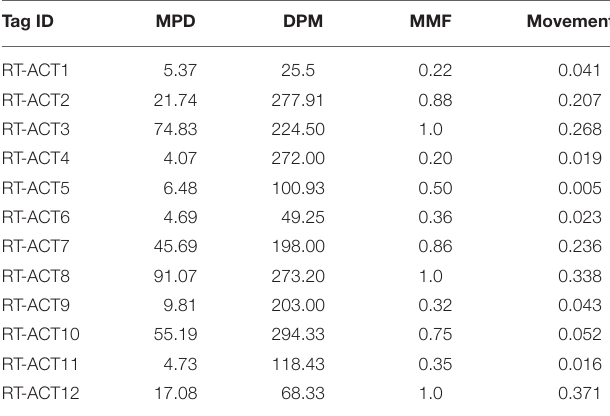
TABLE 5 | Concurrent spatial metrics and accelerometer-derived proportions of time spent moving (Movement) for the entire ACT-logging period. Tag